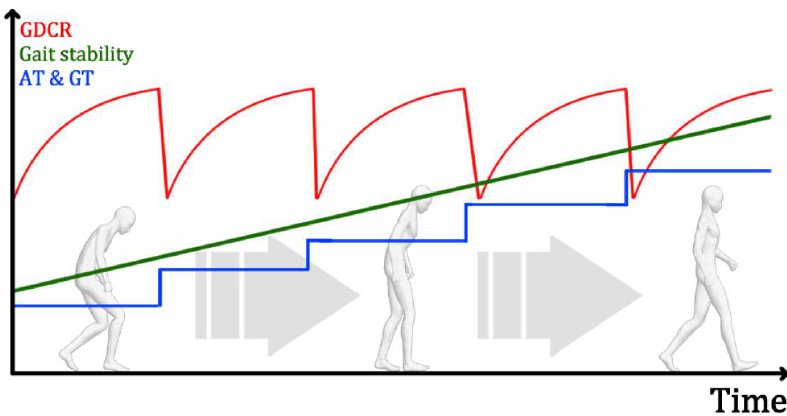
Figure 8. Application of the GDC method. The GDC method could be used for rehabilitation.